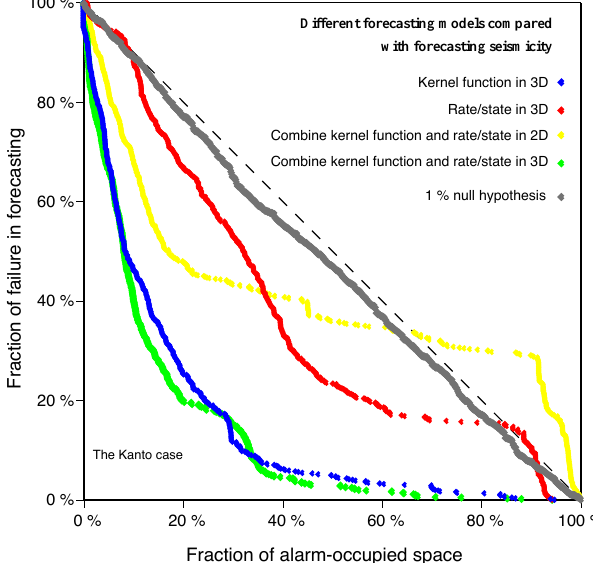
Figure 9. The Molchan diagram used for investigating the correla- tion between different forecasting models and earthquakes during the forecasting period (January 2010–August 2011) for the Kanto case. Blue and red dots denote the results for the models using solely the smoothing kernel function and the rate-and-state friction model, respectively; yellow and green dots denote the results for the combination of the two models in two- and three-dimensional grids, respectively; grey dots represent the 99% significance level determined by 703 forecasting